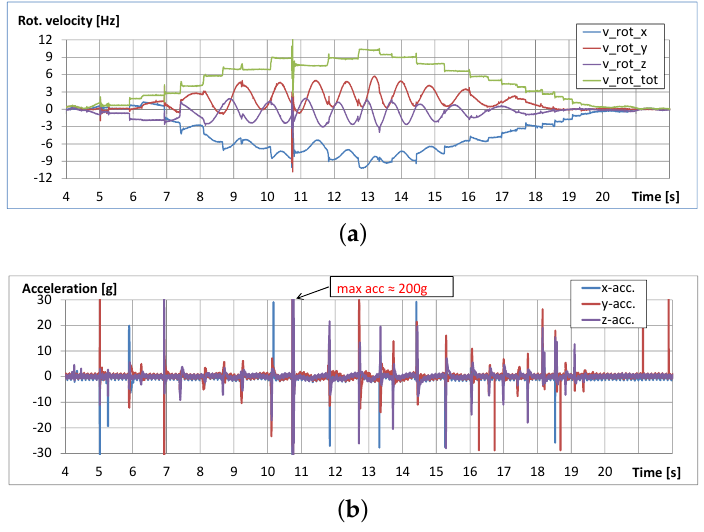
Figure 13. Example (Test 9) for the measured ( a ) rotational velocities and ( b )